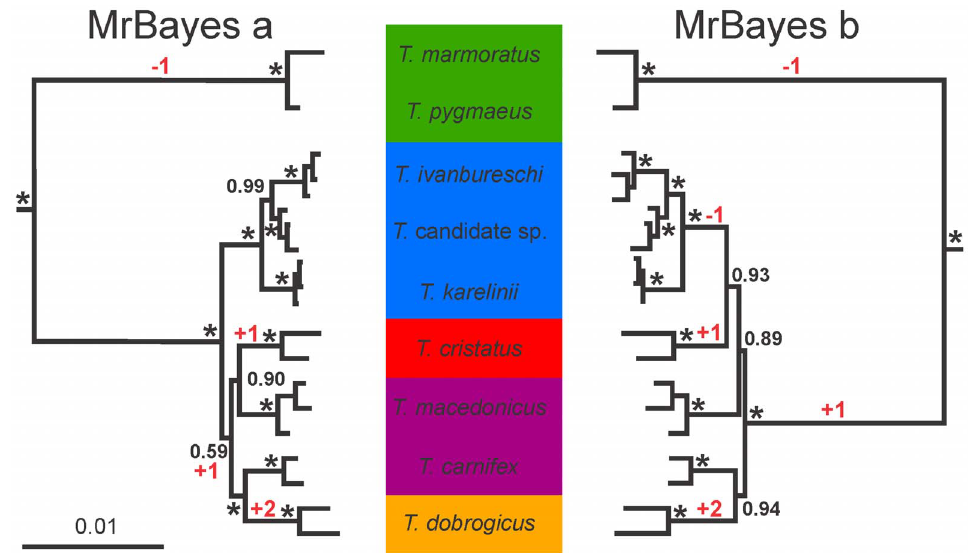
Figure 3. Species trees resulting from the concatenation-based estimation in MrBayes for the genus Triturus , based on 38 nuclear markers positioned in 3 9 untranslated regions, sequenced for 20 individuals. Internal branches supported with pp=1.0 are marked with an asterisk. Analyses a and b reflect two different input files used which, for heterozygote marker-individual combinations, include either one or the other allele. The inferred position of the root for Triturus is shown. Background colors reflect variation in the number of rib-bearing pre-sacral vertebrae characterizing Triturus morphotypes as in Fig. 1 and the character stage changes required are noted in red. doi:10.1371/journal.pone.0111011.g003 moved to form a sister group with T. dobrogicus (Fig. 5). One of of T. cristatus differs between replicates). In the first replicate of the MrBayes phylogenies (‘‘MrBayes b’’ in Fig. 3) implies six the BUCKy phylogeny (‘‘Bucky a’’ in Fig. 4) the position of T. character state changes in the number of rib-bearing pre-sacral carnifex and T. cristatus need to be switched. In the *BEAST vertebrae, whereas the other estimates of the Triturus species tree phylogeny (i.e. the coalescent-based analysis) T. cristatus should be